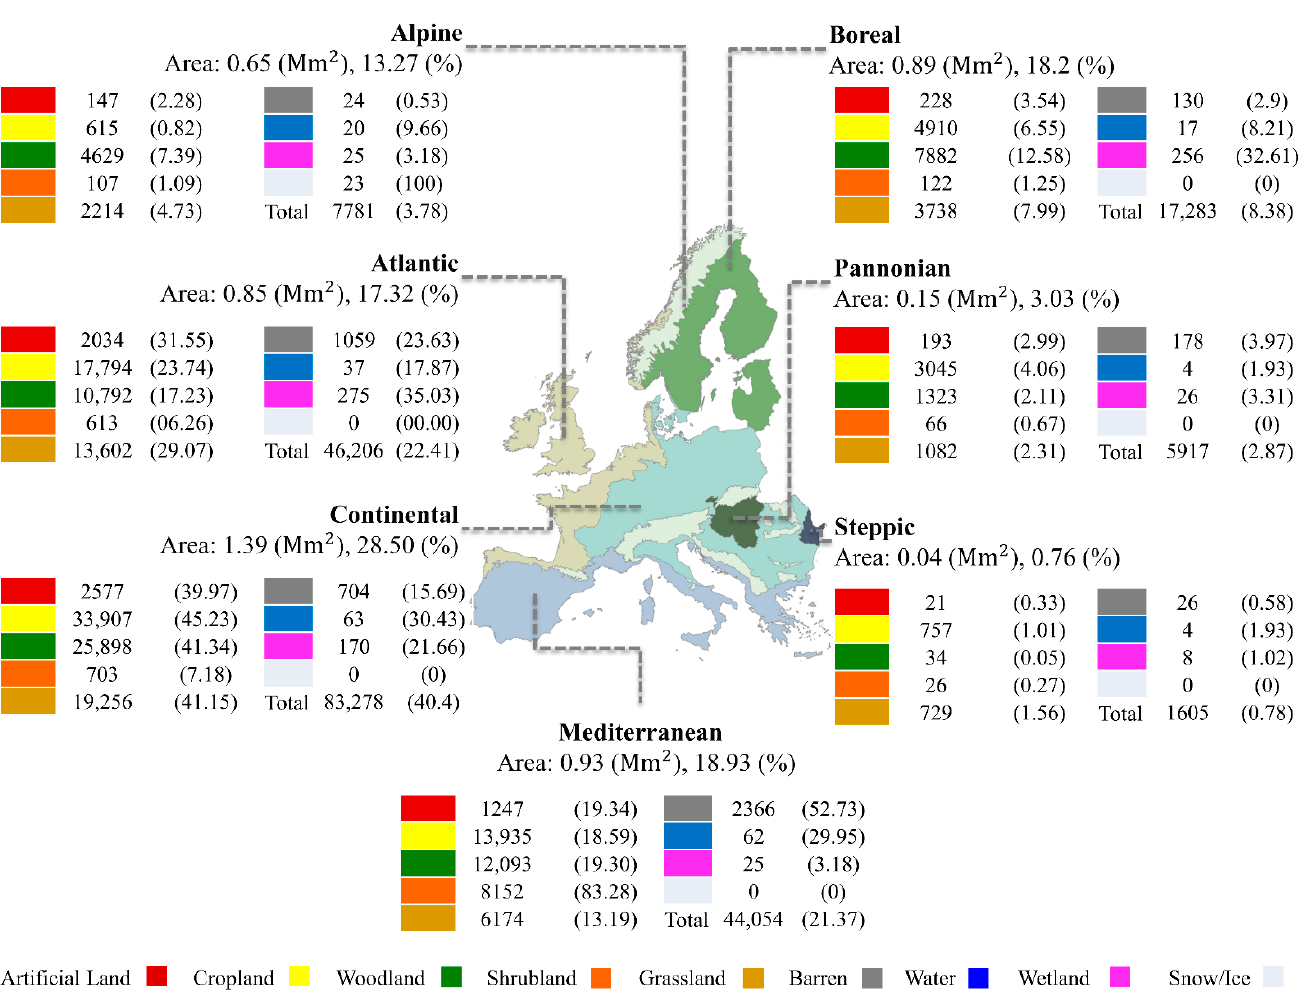
Figure 1. The number of each sample in European biogeographical regions and percentage (within parentheses) of each class to the total number of the correspondent class, along with the area (Mm 2 , %) of the biogeographical regions.